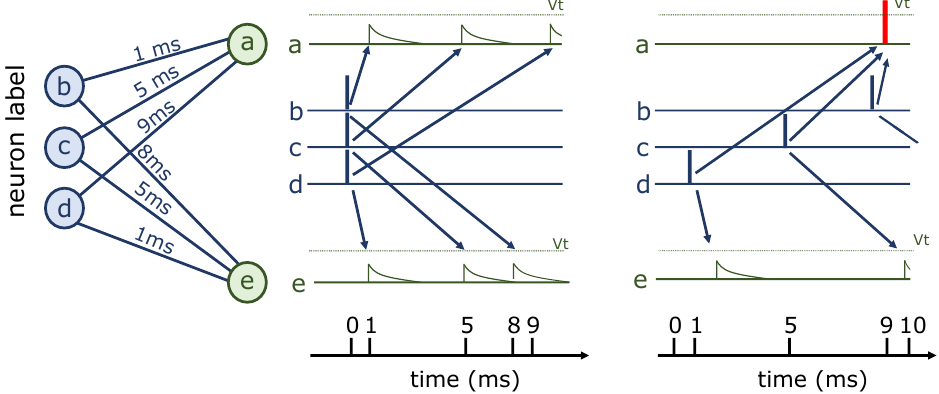
Figure 6. Core mechanism of polychrony detection [111]. ( Left ) In this example, three presynaptic neurons denoted b , c and, d are fully connected to two post-synaptic neurons a and e , with different delays of respectively 1, 5, and 9 ms for a and 8, 5, and 1 ms for e . ( Middle ) If three synchronous pulses are emitted from presynaptic neurons, this will generate post-synaptic potentials that will reach a and e asynchronously because of the heterogeneous delays, and they may not be sufficient to reach the membrane threshold in either of the post-synaptic neurons; therefore, no spike will be emitted, as this is not sufficient to reach the membrane threshold of the post synaptic neuron, so no output spike is emitted. ( Right ) If the pulses are emitted from presynaptic neurons such that, taking into account the delays, they reach the post-synaptic neuron a at the same time (here, at t = 10 ms), the post-synaptic potentials evoked by the three pre-synaptic neurons sum up, causing the voltage threshold to be crossed and thus to the emission of an output spike (red color), while none is emitted from post-synaptic neuron e